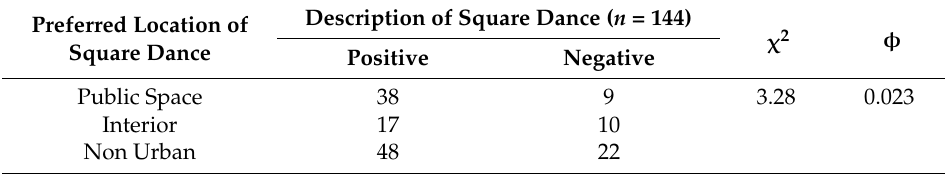
Table 13. Chi Squared Test comparing the description of square dance to the preferred location of Square Dance.